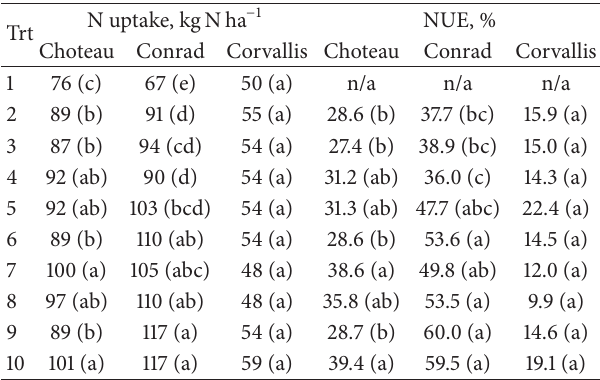
Table 8: Mean spring wheat N uptake and NUE, Choteau, Conrad, and Corvallis,